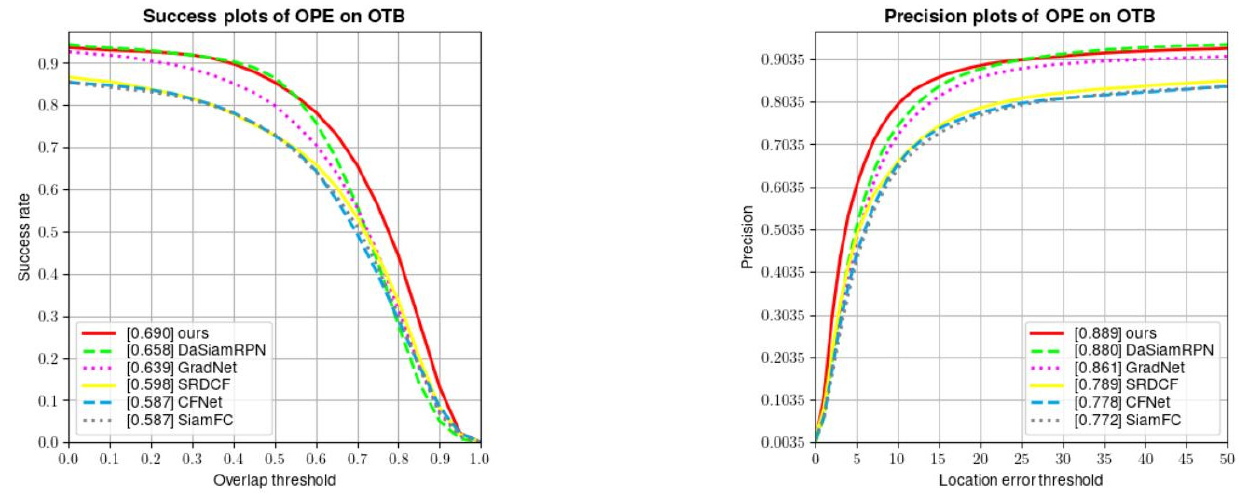
Figure 7. Performance of different algorithms on OTB100 dataset. Table 2. Precision under different attributes. The best three results are marked in red, green, and blue bold fonts, respectively.